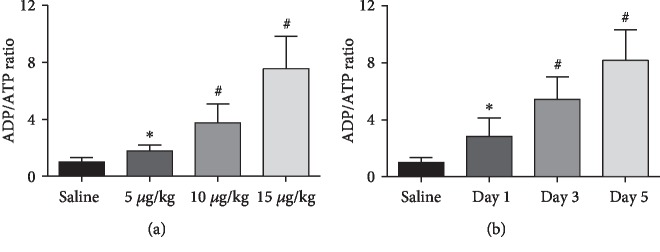
Cardiac mitochondrial ADP/ATP ratios in saline- and DOX-treated mice. (a) The effects of different DOX doses on cardiac mitochondrial ADP/ATP ratios were determined. (b) The effects of DOX on cardiac mitochondrial ADP/ATP ratios at different time points were measured. N = 6 in each group. ∗P < 0.05 vs. saline group; #P < 0.01 vs. previous concentration and time point.